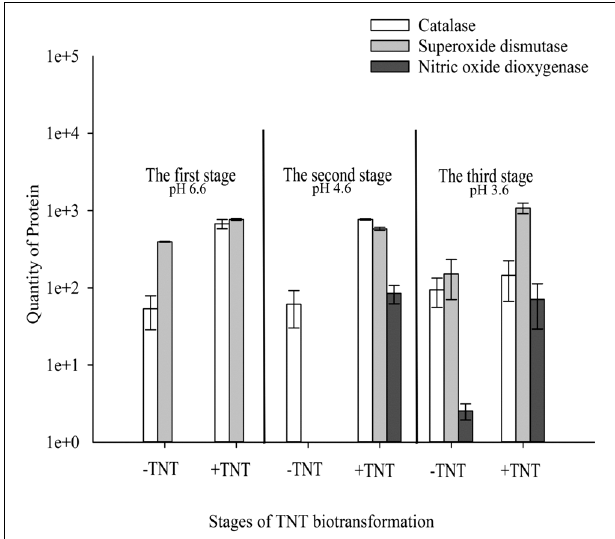
FIGURE 4 | Quantitative changes of up-regulated intracellular proteins of Y. lipolytica involved in detoxification of reactive oxygen and nitrogen species during all stages of TNT biotransformation. Error bars represent the standard deviation of duplicate biological experiments with two technical